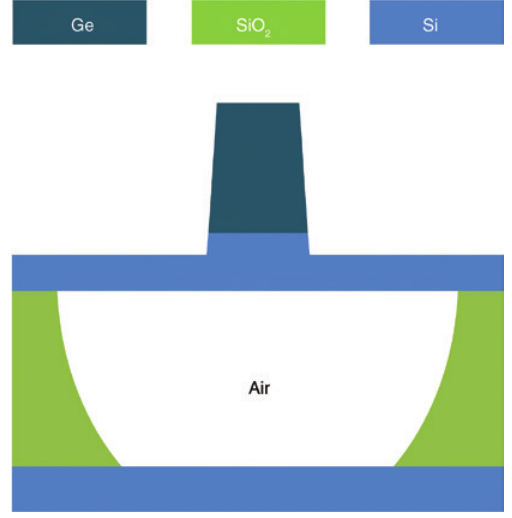
Figure 1: Cross-section of the CMOS-compatible dispersion- flattened Ge-on-Si waveguide with SiO